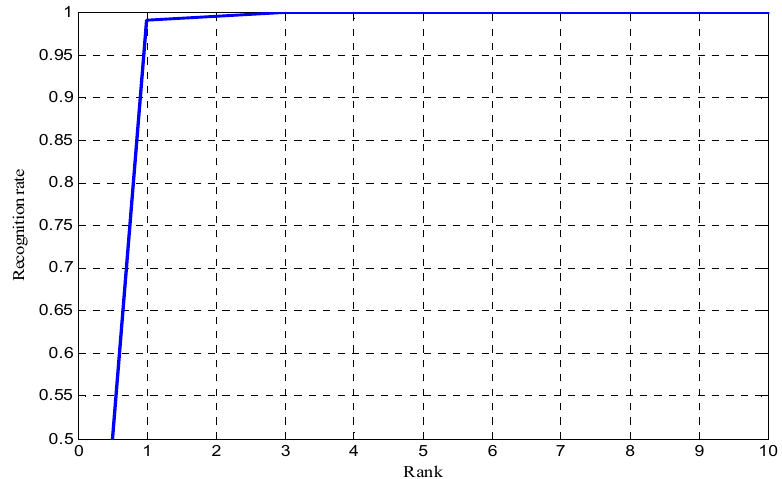
Figure 13. Cumulative match characteristic (CMC) curve for proposed face-iris multimodal system on CASIA-FERET database.